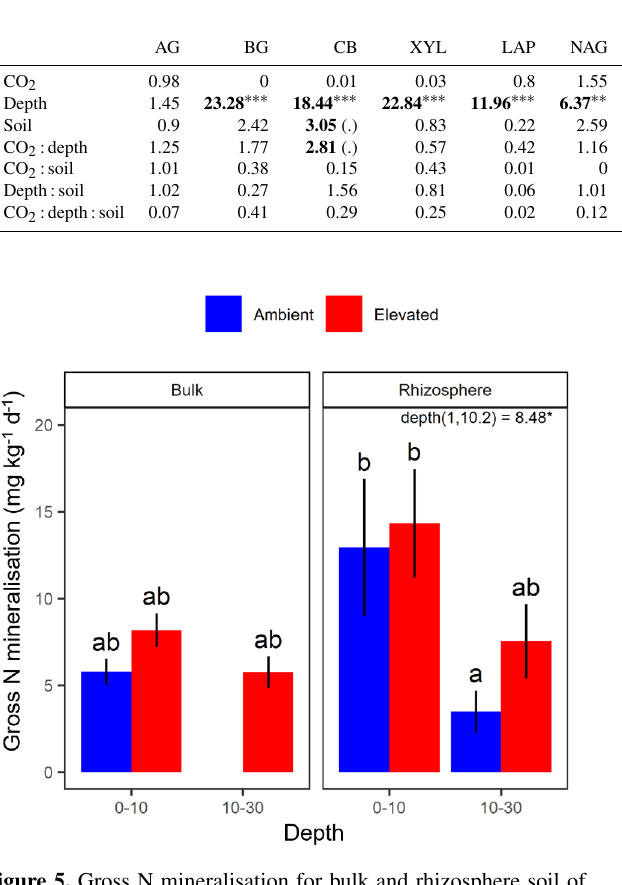
Figure 5. Gross N mineralisation for bulk and rhizosphere soil of the mature Eucalyptus forest soil exposed to ambient (blue) and el- evated (red) CO 2 for two depths (0–10 and 10–30cm). Error bars indicate the standard error. The mixed-effects model output is stated (degrees of freedom and Df residuals), and the F statistic is pre- sented. Asterisks for the P value for significance are provided, where ∗ indicates P< 0 . 05. Results from statistical analysis of com- parison of soil types (bulk and rhizosphere) are presented in Table 1.